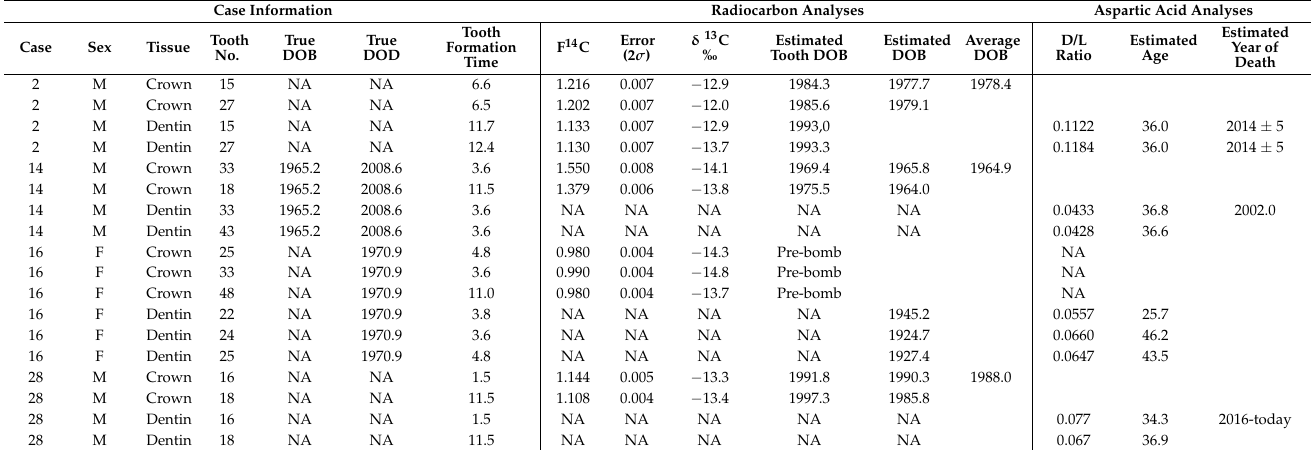
Table 4. Results of AAR analysis of teeth in four of the